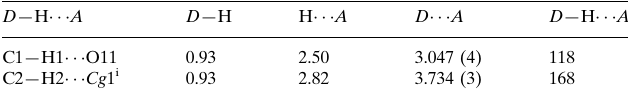
Hydrogen-bond geometry (A ˚ , (cid:2) ). Cg 1 is the centroid of the C22–C27 ring.